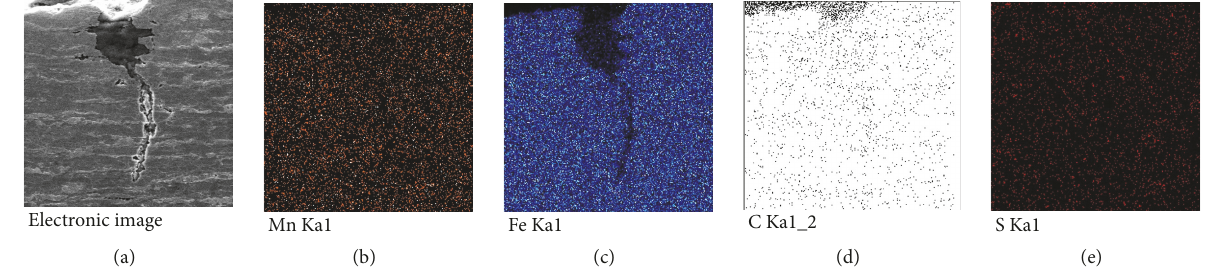
Figure 11: Maps of elements distribution in a stress corrosion crack: (a) electronic image of the crack; (b) distribution of manganese; (c) distribution of iron; (d) distribution of carbon; (e) distribution of